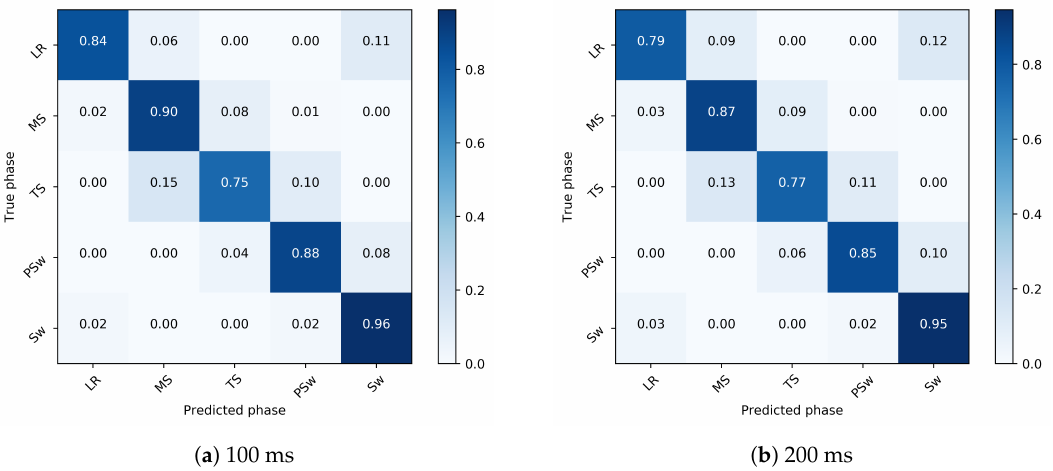
Figure 8. Confusion matrix showing the gait phase prediction accuracy of 100 ms ( a ) and 200 ms ( b ) ahead in the inter-subject implementation. The true gait phase is shown on the y -axis and the predicted phase is on the x -axis. A strong diagonal indicates a very accurate prediction, and misclassifications are indicated off the